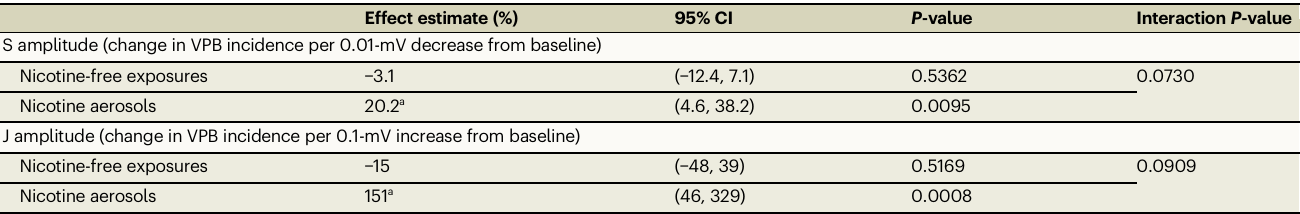
Table 1 | Estimated association of changes in ECG repolarization parameters with VPB incidence upon inhalation exposure to nicotine-free and nicotine-containing aerosols